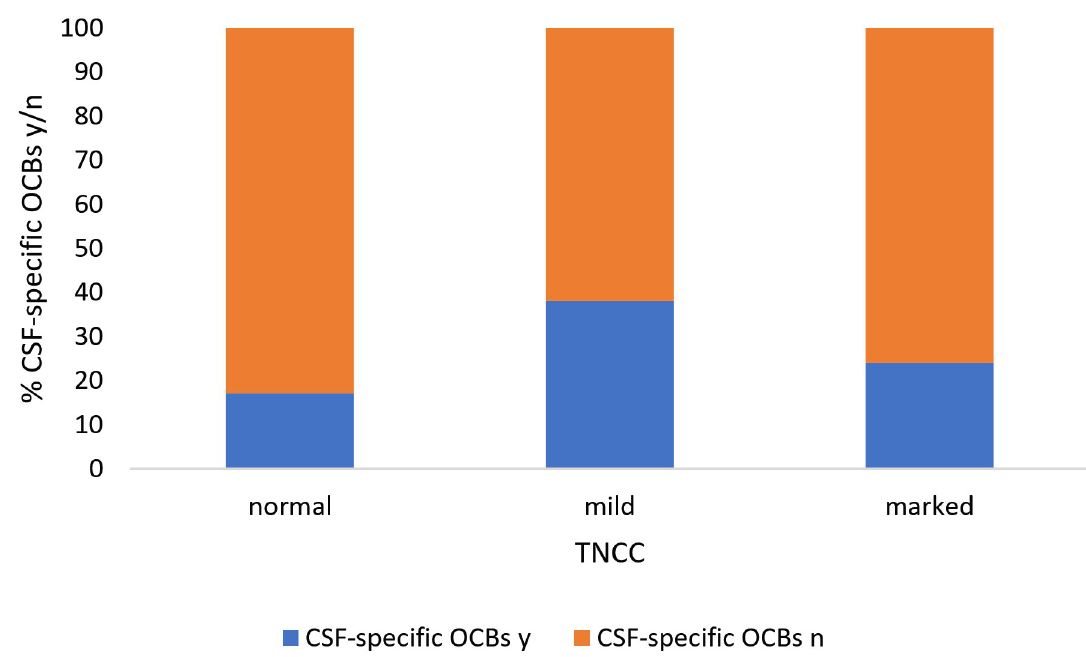
Fig 4. Association between presence of CSF-specific OCBs and TNCC. There was no association between presence of CSF-specific OCBs and increased TNCC present (p > .11). CSF = cerebrospinal fluid, OCB = oligoclonal band, y = yes, n = no, TNCC = total nucleated cell